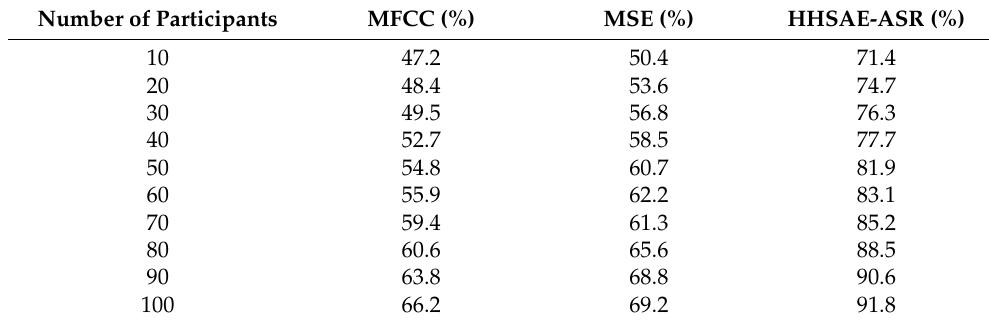
Table 3. Data accessing